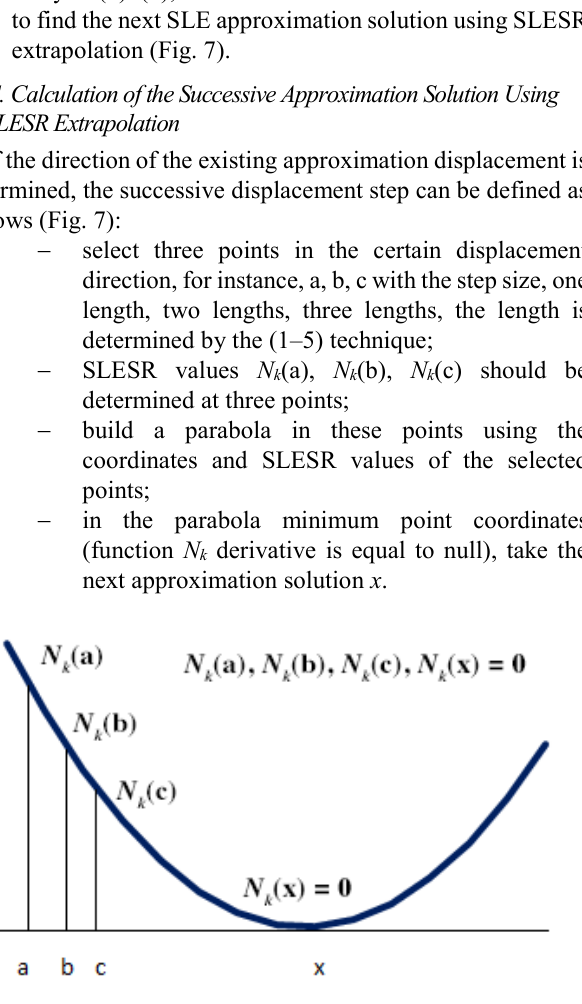
Fig. 7. Successive iteration in determination of a displacement step